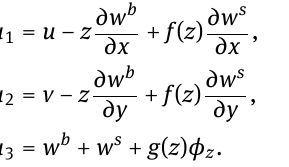
u 2 = v − z u 3 = w b + w s